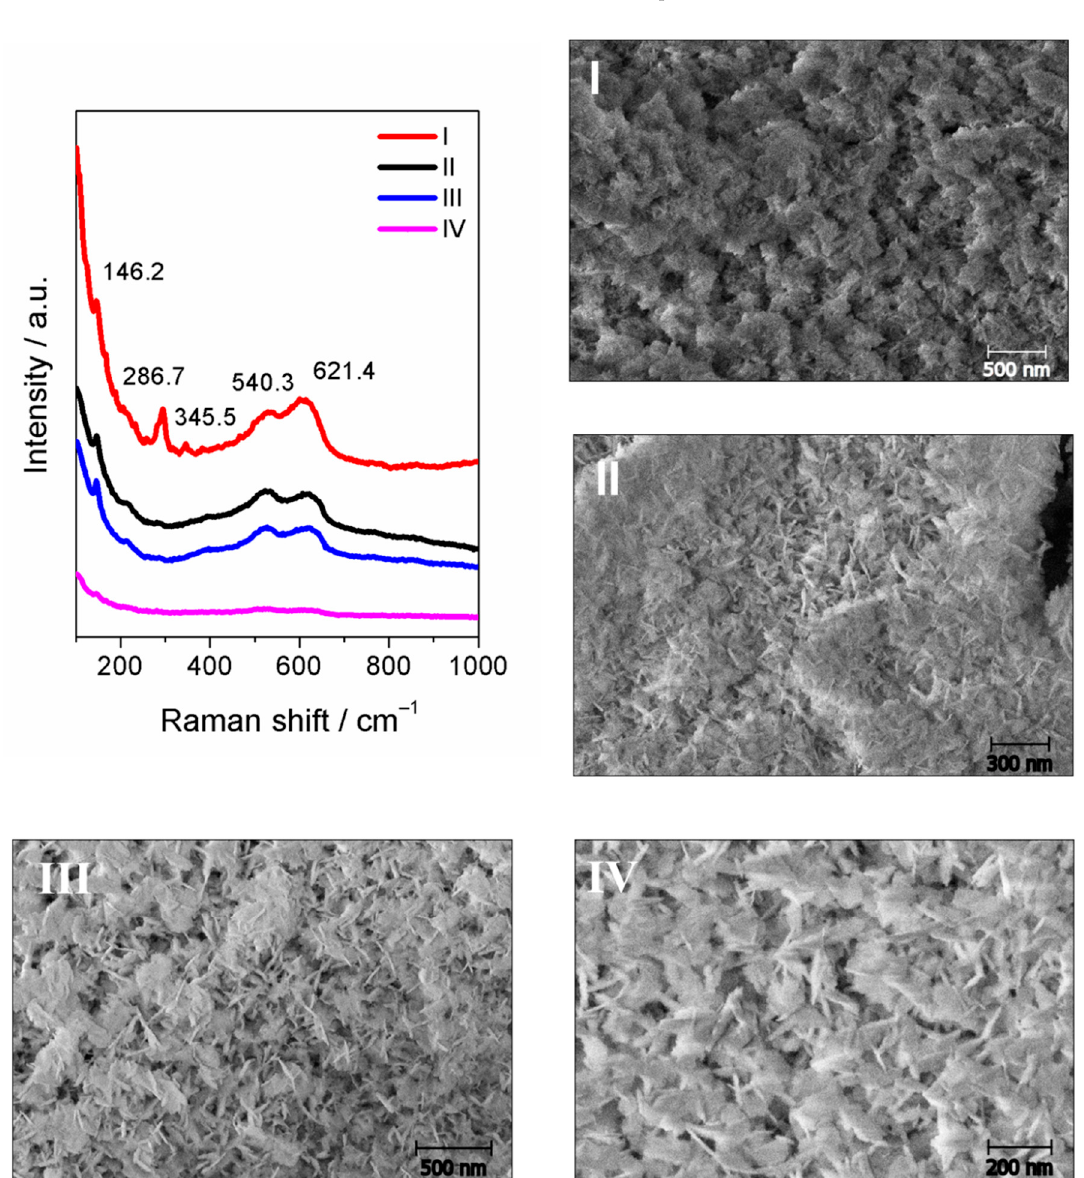
Figure 4. Raman spectra and FESEM images ( I – IV ) of copper oxides nanoneedles synthesized by electrochemical anodiza- tion at 10 V, for 3 min and 5 °C, using X% v / v H 2 O (I = 5.0, II = 1.5, III = 1.0, IV = 0.5) + 0.1 M NaOH + 0.1% w / v NH 4 F, dissolved in ethylene glycol.